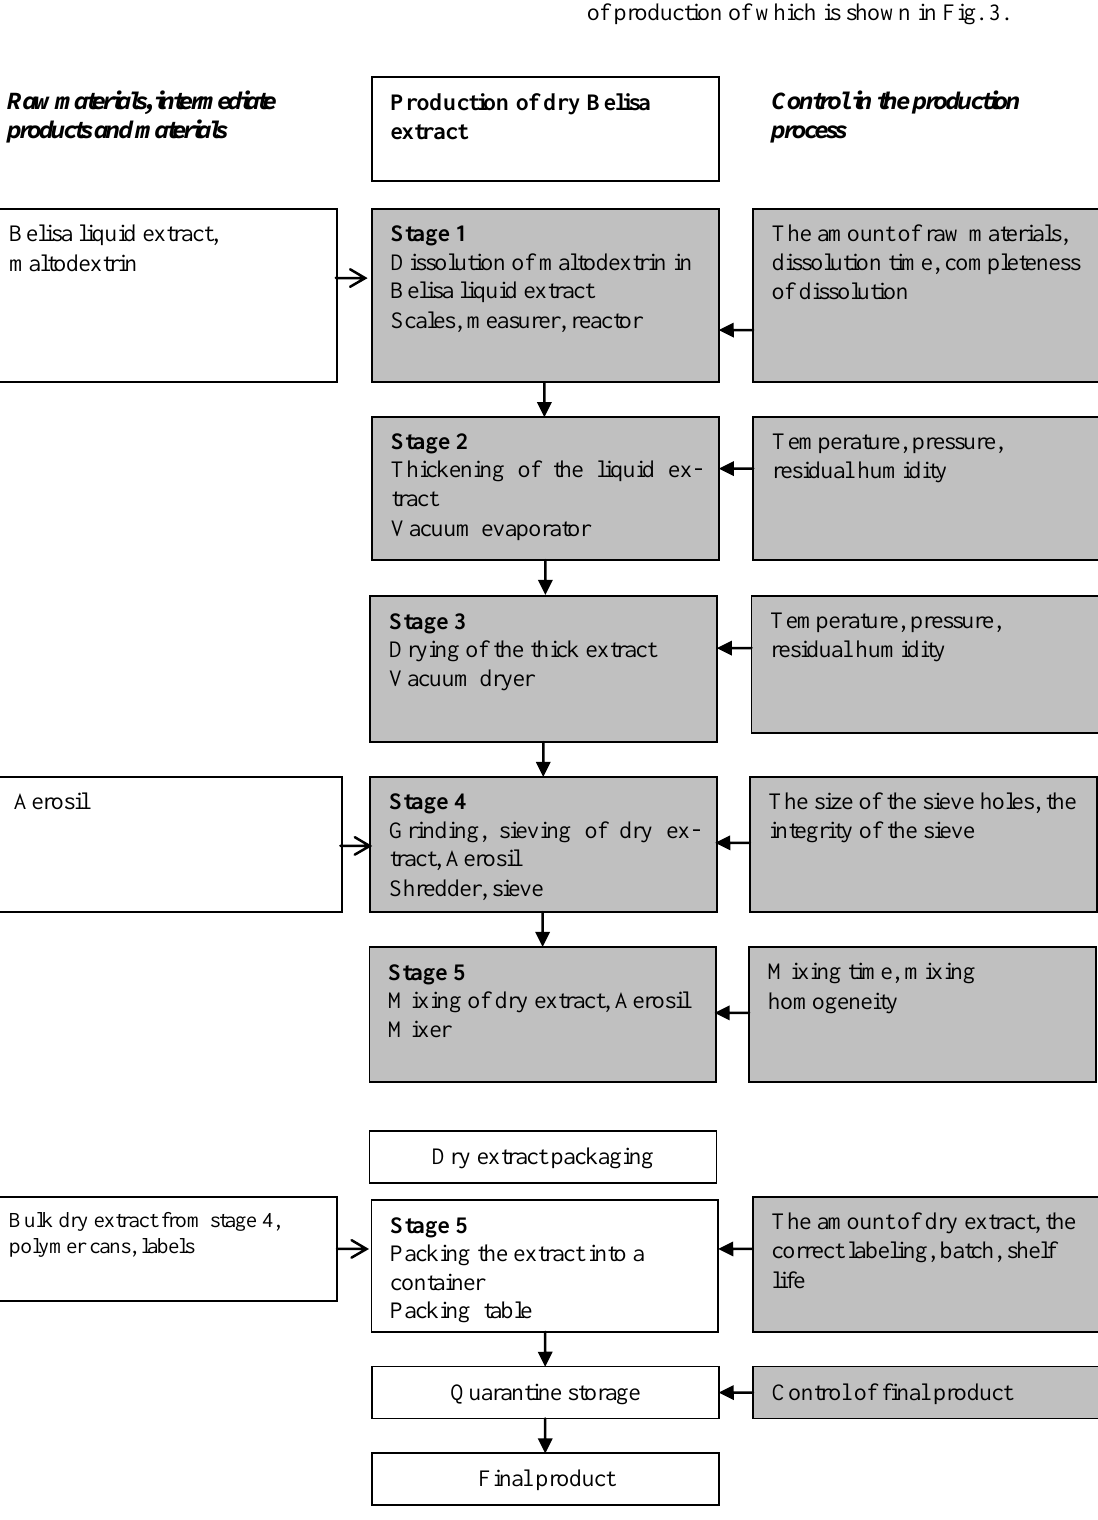
Fig. 3. Technological scheme of production of dry Belisa extract (sample No.